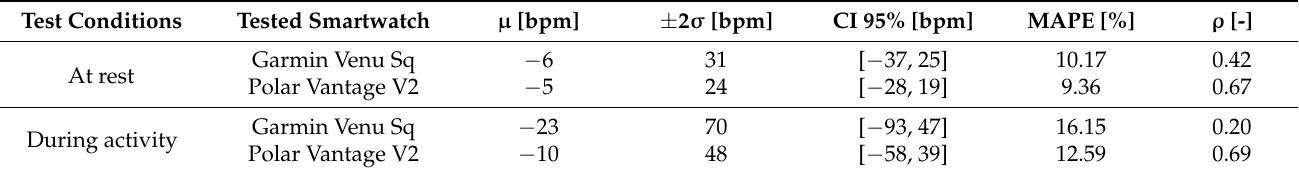
Table 5. Metrological performance of the tested smartwatches in terms of measurement accuracy ( µ ) and precision ( ± 2 σ ), confidence interval at 95% (CI95%), mean absolute percentage error (MAPE), and Pearson’s correlation coefficient ( ρ )–results obtained at rest vs. during